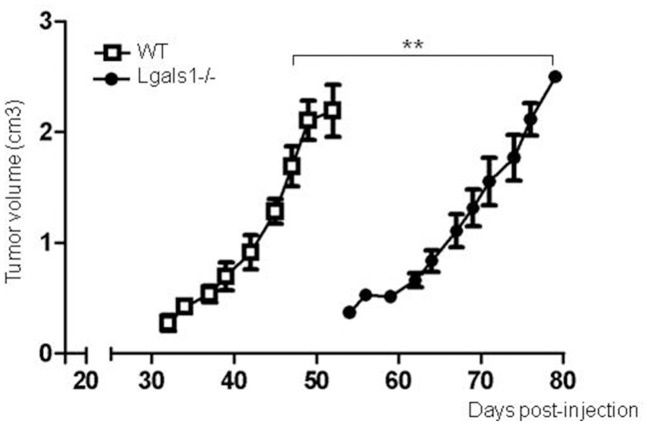
Endogenous Gal-1 in lymphocytes accelerates in vivo TRAMP-C1 tumor growth. Adult male nude mice were reconstituted with experienced immune cells from wild-type (white squares; n = 5) and Lgals1-/- (black circles; n = 6) mice. The day after, the mice received 1 × 106 TRAMP-C1 in Matrigel®, and tumor growth was monitored by volume measures. **p < 0.01, t-test.